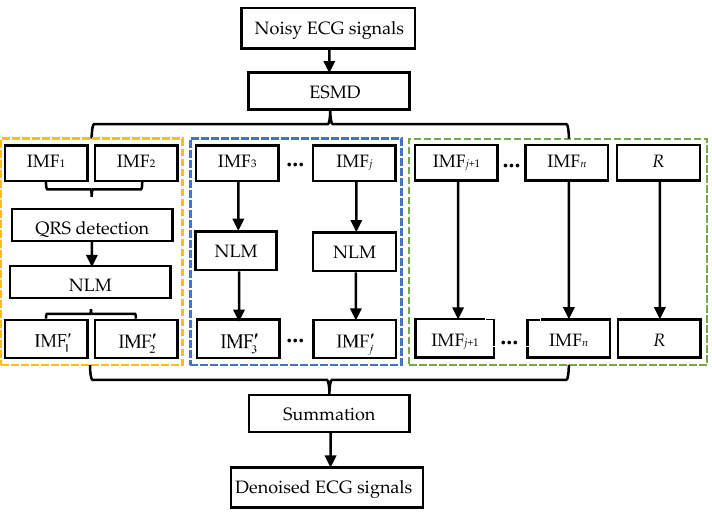
Figure 3. The flowchart of the ESMD-based NLM method for ECG signal denoising.